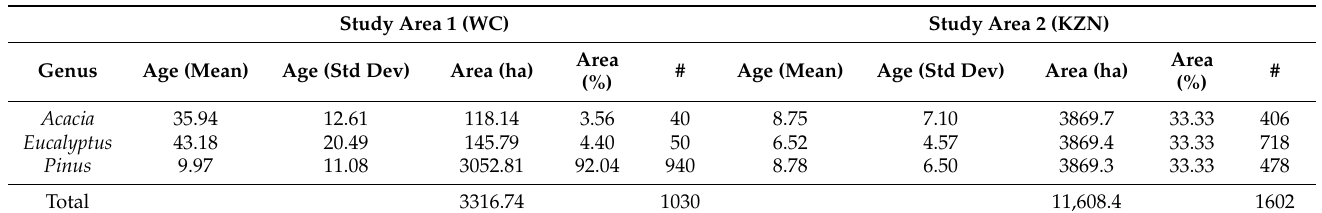
Table 3. Summary of in situ data (forest compartment information) collated, including tree genus, age (mean and standard deviation), and planted area per study